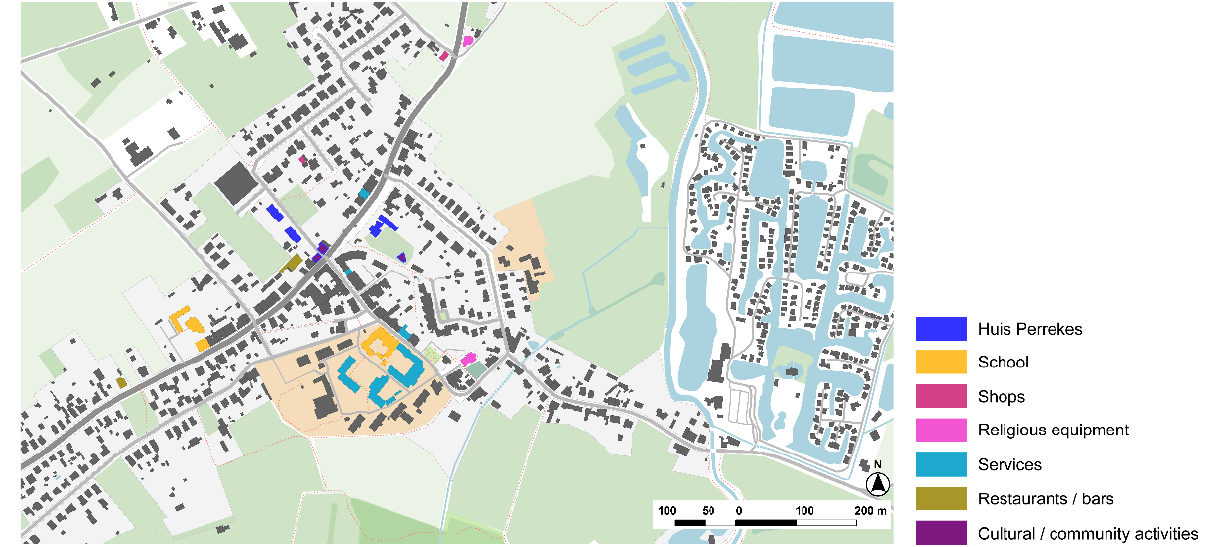
Figure 17. Main buildings of Huis Perrekes and services in Osterloo, Geel, Belgium. Source: Own